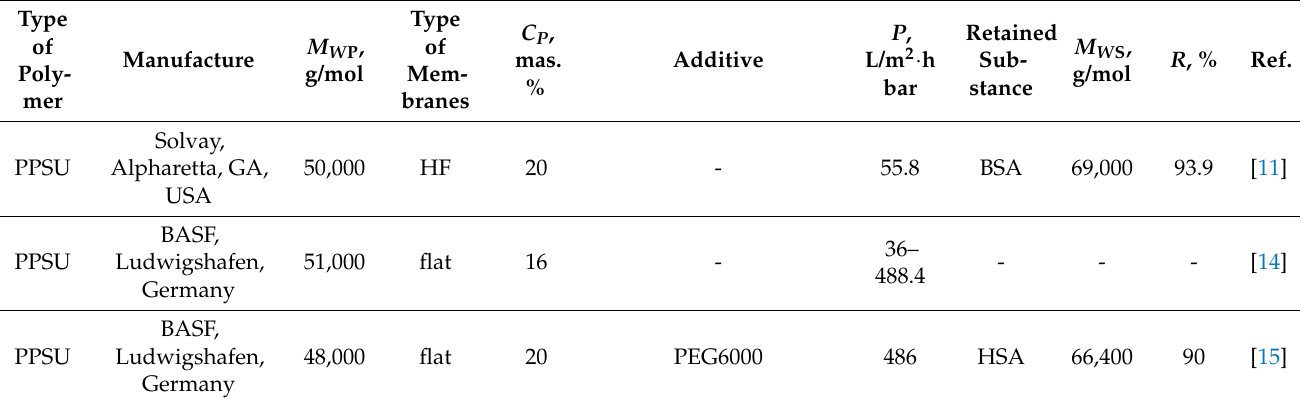
Table 1. Literature data on UF membranes based on